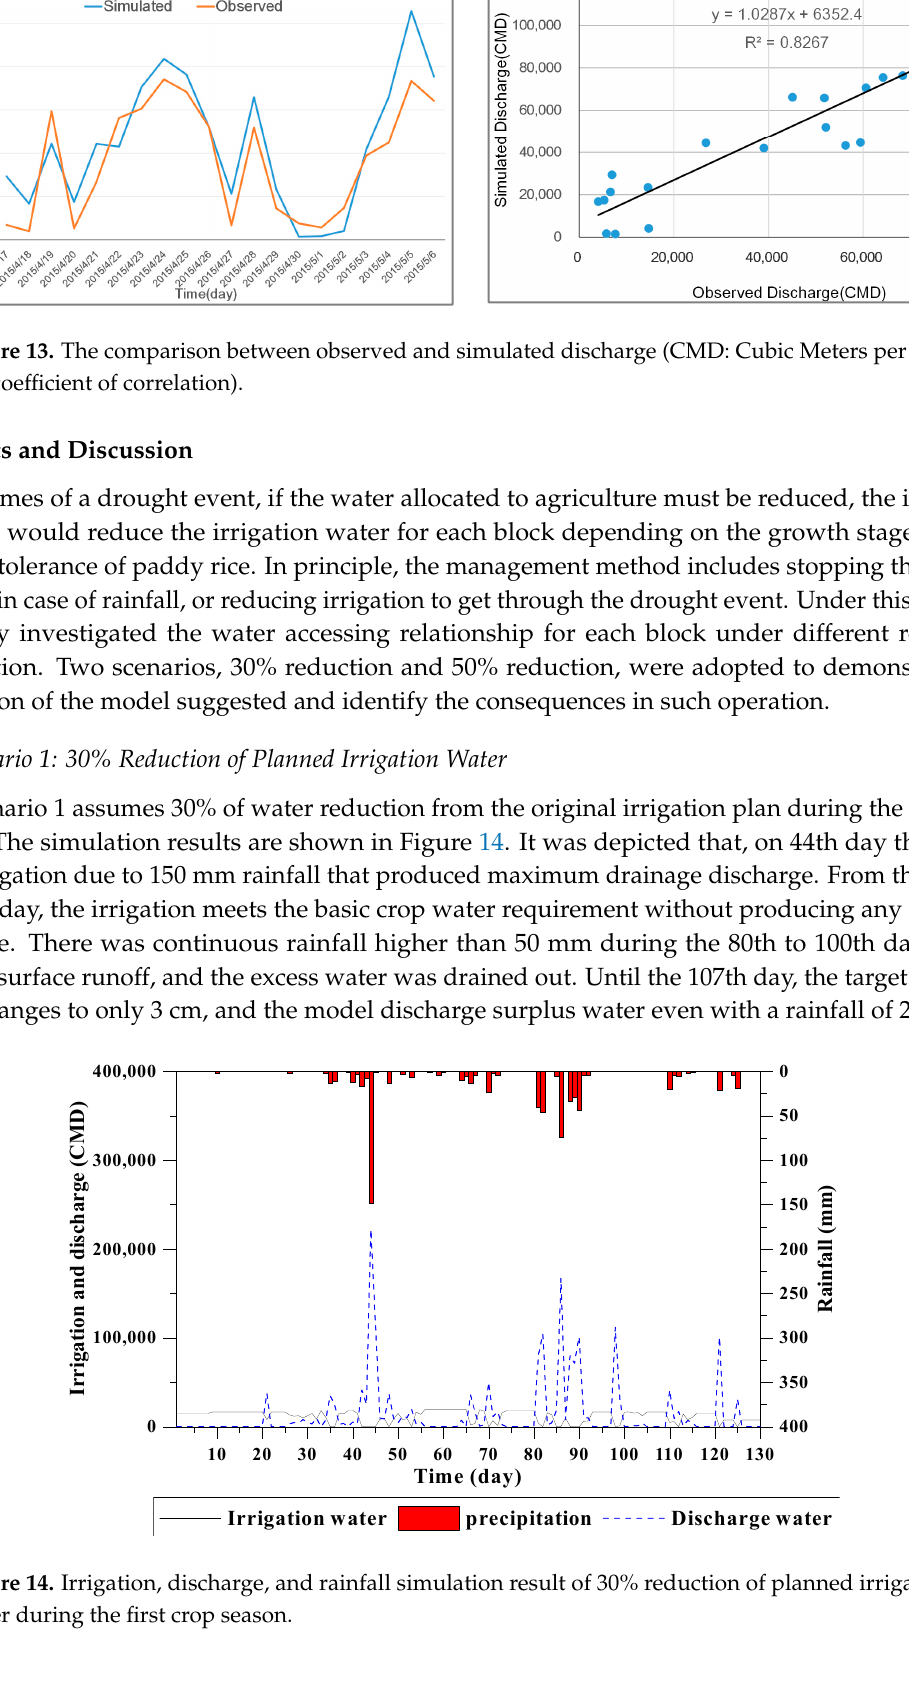
Figure 15. Simulation of block 1 under 30% reduction of planned irrigation water during the first crop season. Figure 16. Simulation of block 2 under 30% reduction of planned irrigation water during the first crop season.